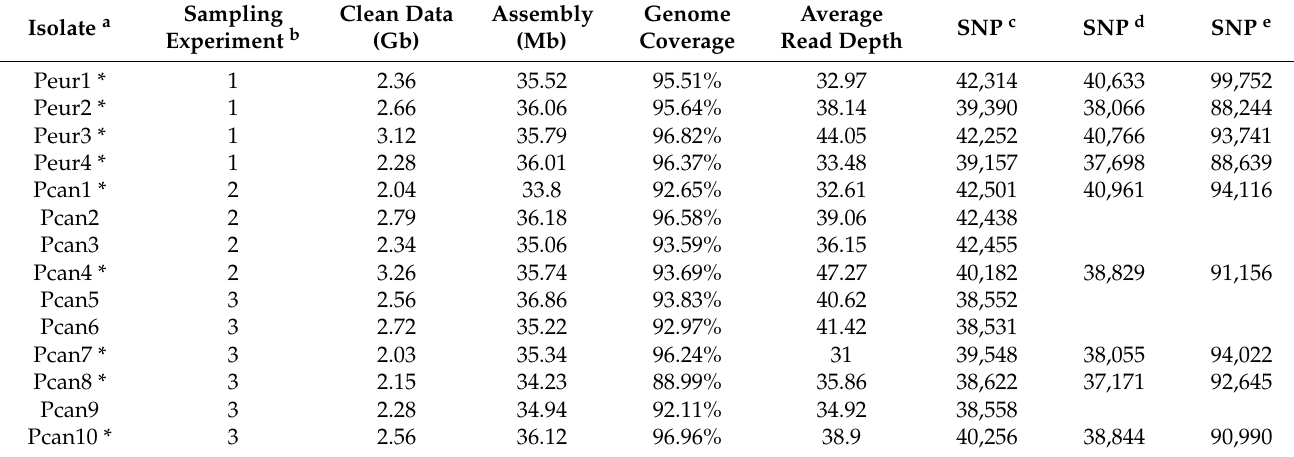
Table 1. M . brunnea isolates sampled in this study and associated data.